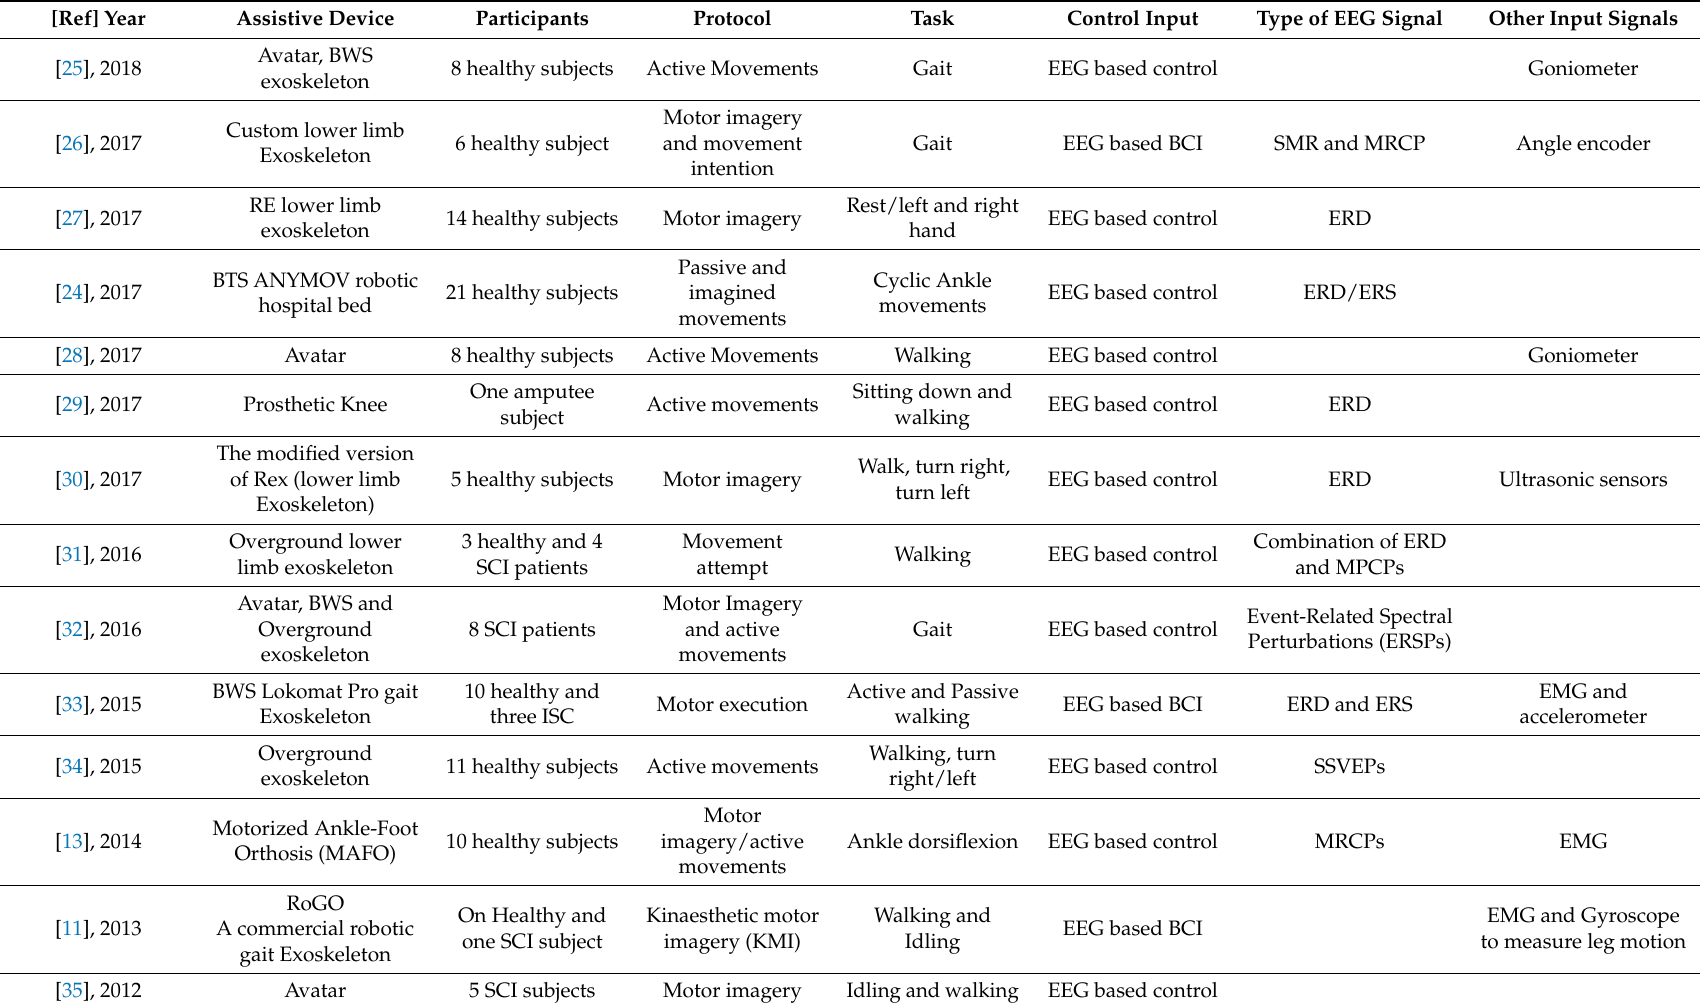
Table 2. EEG-based control for lower limb